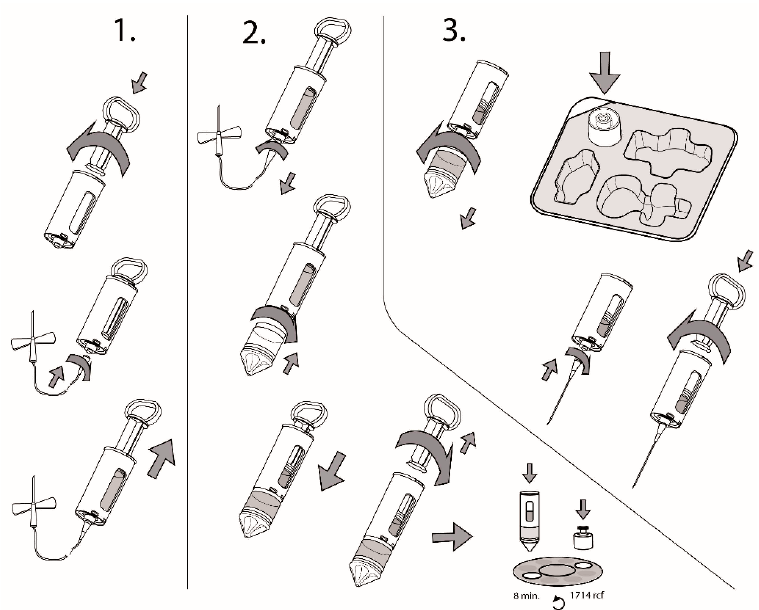
Figure 2. The user guide for the device. (1) Attach the plunger to the piston by rotating it clockwise and attach the butterfly needle. Place the needle in the vein and draw approximately 12 mL venous blood by pulling the plunger slowly. (2) Remove the needle from the vein and detach the needle from the syringe. Attach the waste container to the syringe and use the plunger to push down of the whole blood manually until the waste container is filled. About 60% of the whole blood is enough to fill the waste container. The whole system weighs now approximately 54 g. Remove the plunger by rotating anticlockwise and pulling it. Centrifuge the syringe for 8 min at 3000 rpm. Platelet rich fibrin (PRF) is formed in the syringe part. (3) Detach the waste container and serum from platelet rich fibrin (SPRF) can be pressed out from the syringe using the plunger; approximately 4.8 mL SPRF can be isolated using one device.